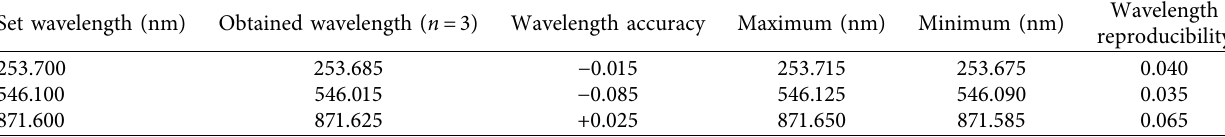
Table 3: Wavelength accuracy and